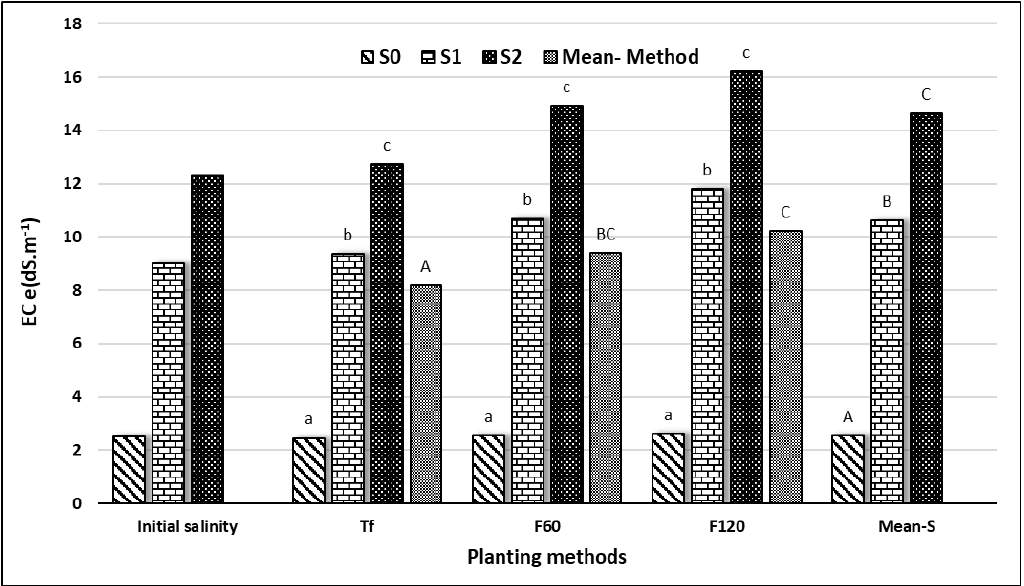
Figure 1. Soil salinity after harvesting under different planting methods and salinity conditions.